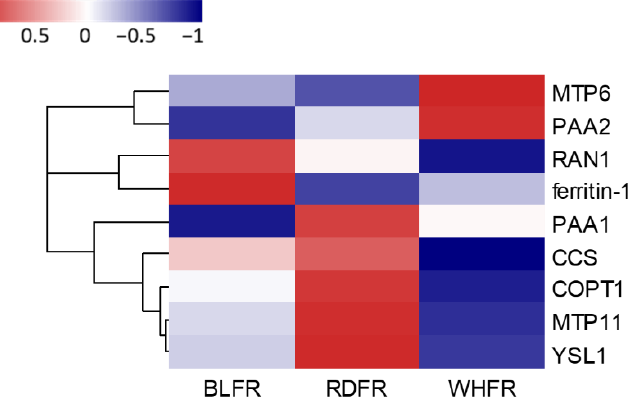
Figure 12. mRNA levels for genes involved in metal accumulation. Red and blue rectangles indicate higher and lower levels, respectively, than the mean of all treatments. Values indicate the z-score in the legend. Significant differences were found in the transcription level of MTP6 , MTP11 , YSL1 , and COPT1 in RDFR vs. WHFR, ferritin-1 and PAA1 in BLFR vs. RDFR, PAA2 and CCS in WHFR vs. others, and RAN1 in all comparison pairs. BLFR, RDFR, and WHFR refer to blue, red, and white light-treated fruits, respectively.